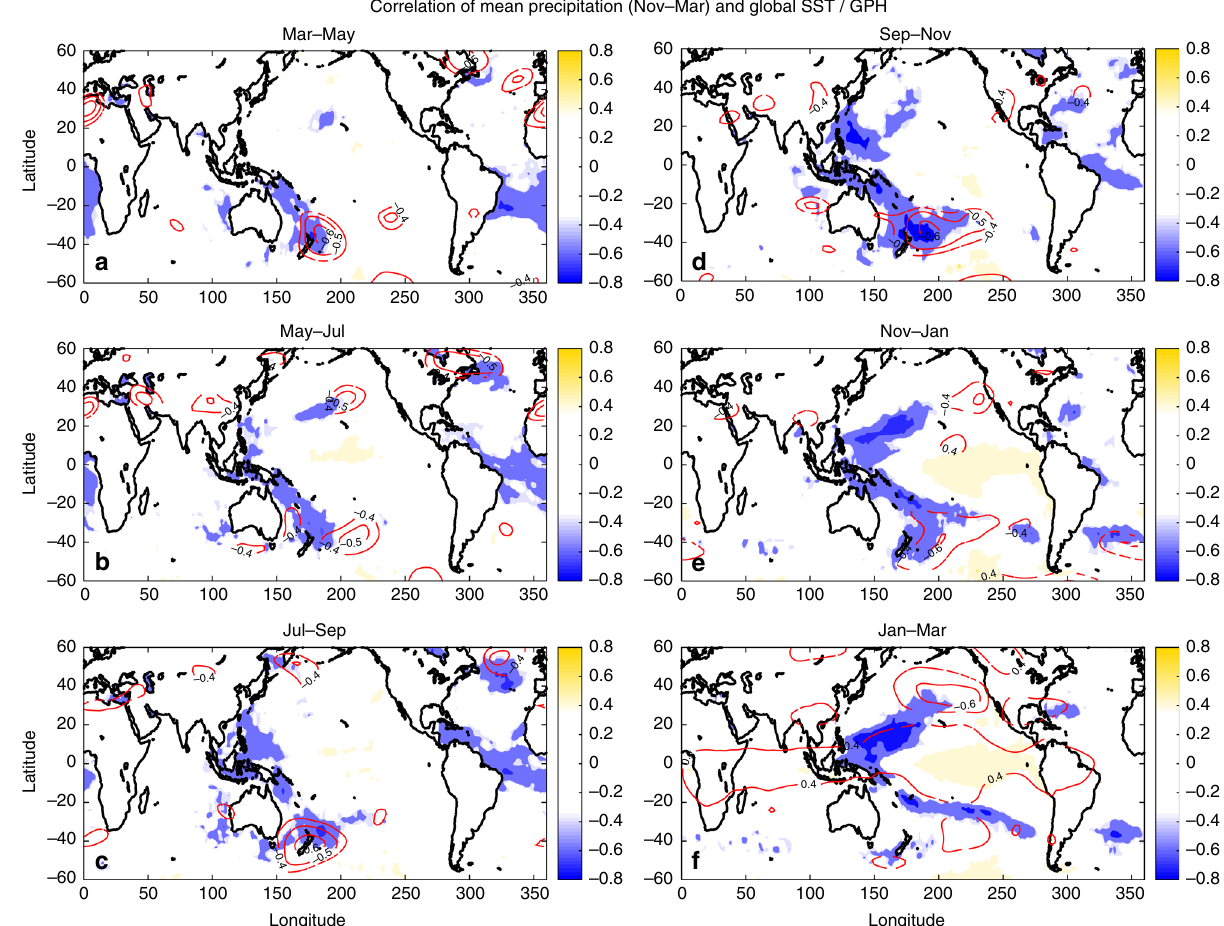
Fig. 4 Within-year evolution of the association of winter precipitation in SWUS with SSTs and GPHs revealed a northward interhemispheric cascade. Correlation maps between average winter precipitation in SWUS (Nov – Mar) and global SST (shading) and GPH (400 mb; contours), for 1982 – 2015. SSTs and GPHs are averaged over different periods, starting Mar – May (previous spring) and ending Jan – Mar. Only statistically signi fi cant correlations are shown ( α = 0.05 signi fi cance